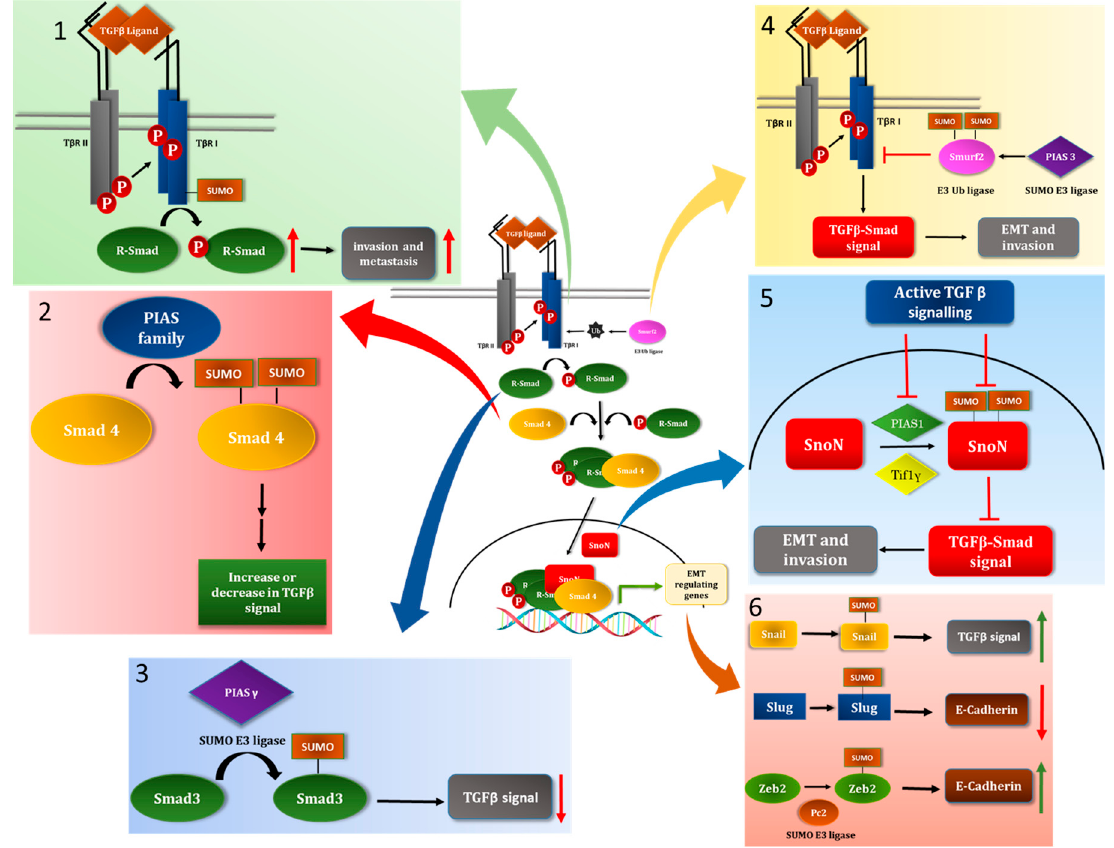
Figure 3. SUMOylation system and TGF β -signaling interplay in the context of induction of epithelial-mesenchymal transition (EMT). Six schematic models summarizing how the SUMO system and TGF β pathway collaborate or antagonize each other in controlling transcriptional responses that are critical for EMT induction. Briefly, multiple components of the TGF β signaling axis (in centre) as well as EMT-inducing transcription factors (EMT-TFs) can be targeted by the SUMO system with diverse consequences for EMT-related events. TGF β signaling has also been shown to regulate the ability of the SUMO system in targeting such substrates. (1) T β RI as a target of the SUMO system: Lysine residues downstream of kinase domain of T β RI are targets of SUMOylation which can promote the receptor kinase activity and downstream signaling events including R-Smad phosphorylation and transcriptional activity [44]. (2) Smad4 is a target of SUMOylation: The SUMO system targets two Lysine residues in Smad4 for SUMOylation that may lead to diametrically opposite effect on TGF β signaling depending on cell type and context [50–53]. (3) The SUMO system and Smad3: Studies have suggested that Smad3 is SUMOylated, which suppresses Smad3's ability to mediate TGF β signaling [55]. (4) The HECT-containing ubiquitin E3 ligase Smurf2 as a target of the SUMO pathway: Ubc9, promoted by PIAS3, targets specific lysine residues within Smurf2 for SUMOylation. SUMOylation promotes the ability of Smurf2 to reduce the protein abundance of T β RI. Overall, SUMOylation promotes the ability of Smurf2 to suppress TGF β -Smad-induced EMT [56,57]. (5) The transcriptional coregulator SnoN and the SUMO system: Two distinct SUMO E3 ligases, PIAS1 and TIF1 γ , promote the SUMOylation of both Lysine residues 50 and 383 on SnoN. SUMOylation is critical for the ability of SnoN to suppress TGF β -induced EMT. In order to induce EMT, TGF β signaling suppresses SnoN SUMOylation at least in part by increasing the protein turnover of its SUMO E3 ligase PIAS1 [14,58,59]. (6) SUMOylation regulates the activity of several EMT inducing transcription factors: TGF β -induced expression of Snail, Slug, and Zeb2 contribute significantly to EMT induction. Snail, Slug and Zeb2 are targets of the SUMO system. SUMOylation promotes the ability of Snail and Slug to induce EMT, while suppressing Zeb2 role in EMT progression